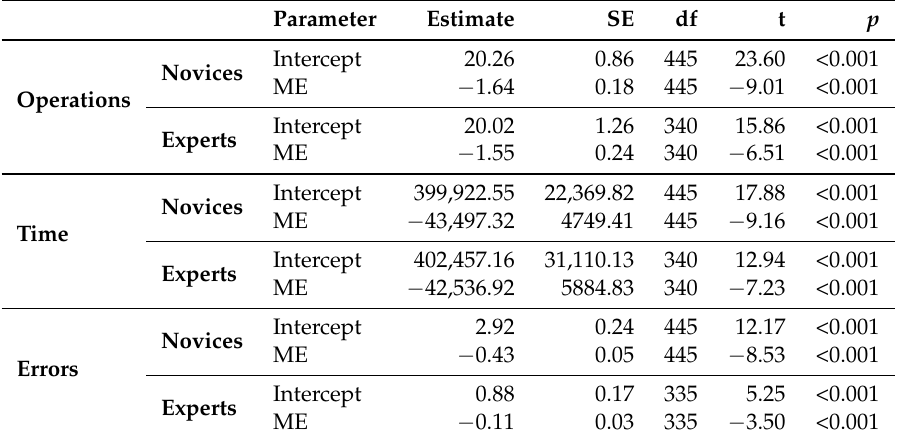
Table 5. Estimates of the multilevel